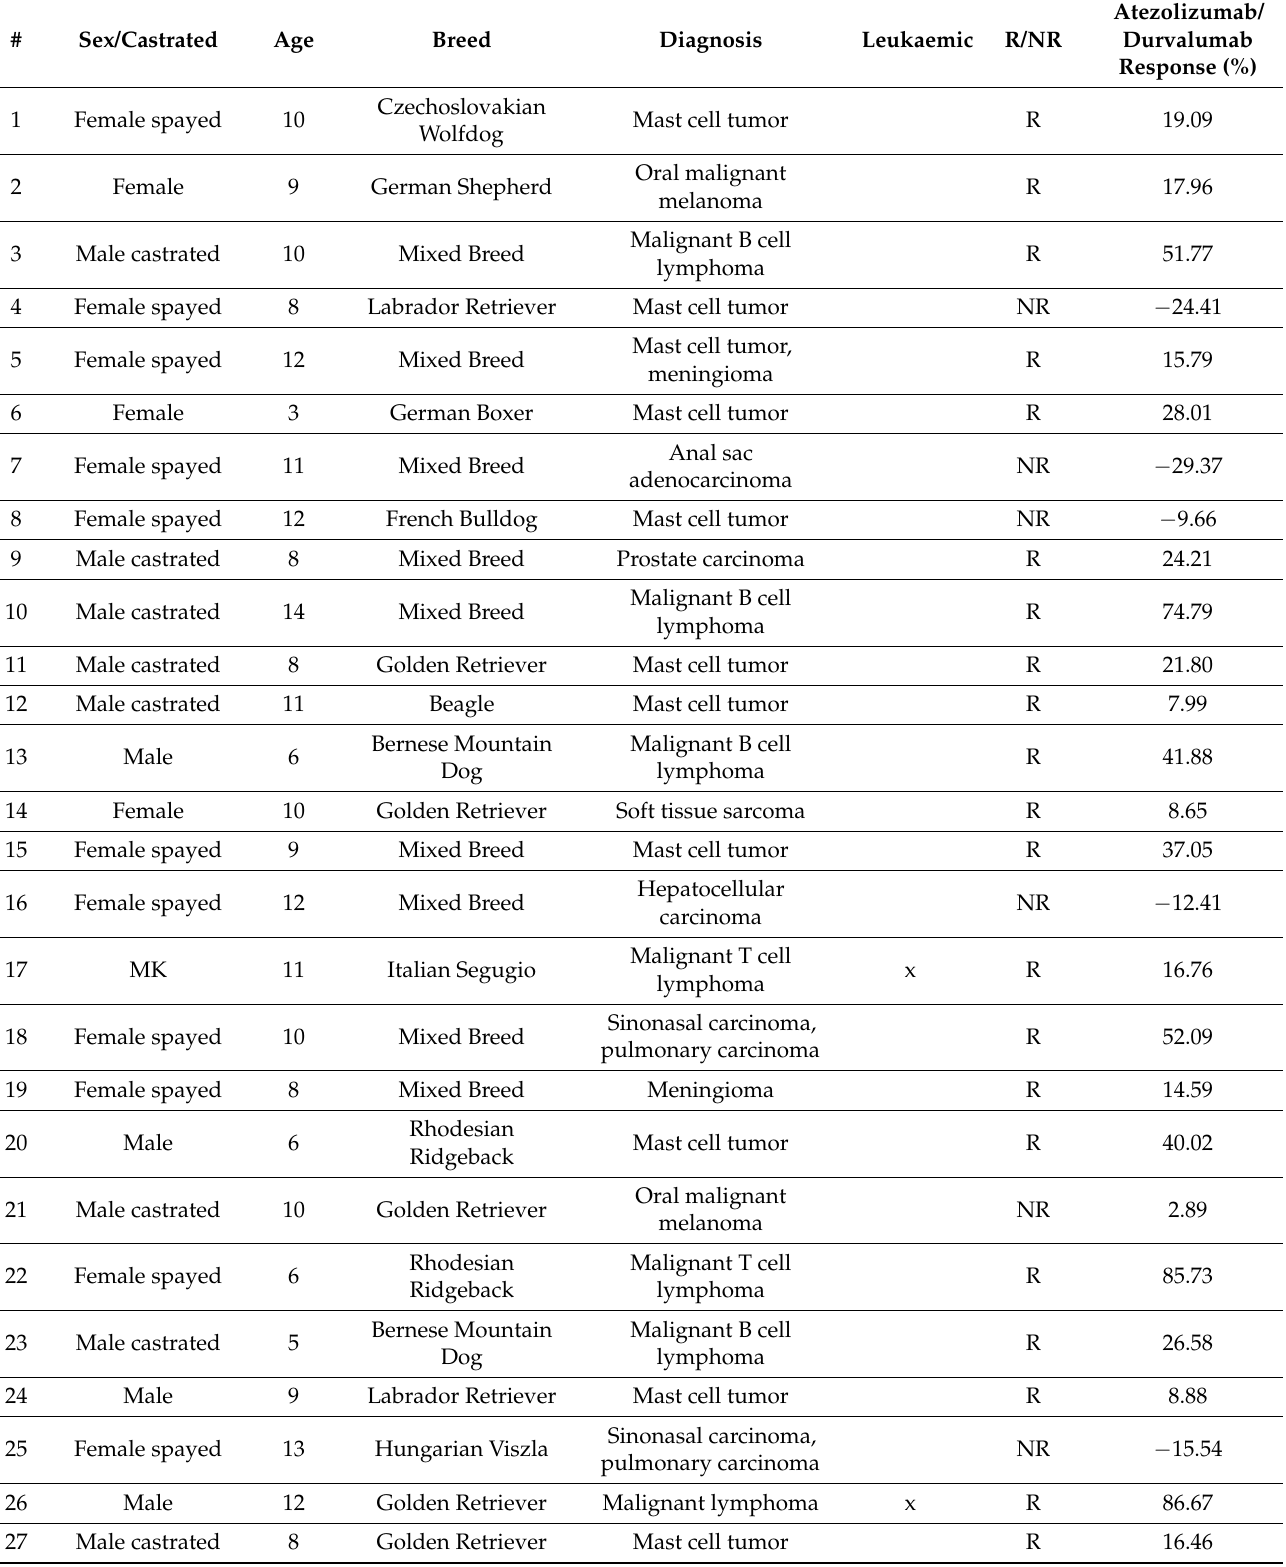
Table 3. Characteristics of cancer patients used in the study. Responders (R), non-responder (NR) to